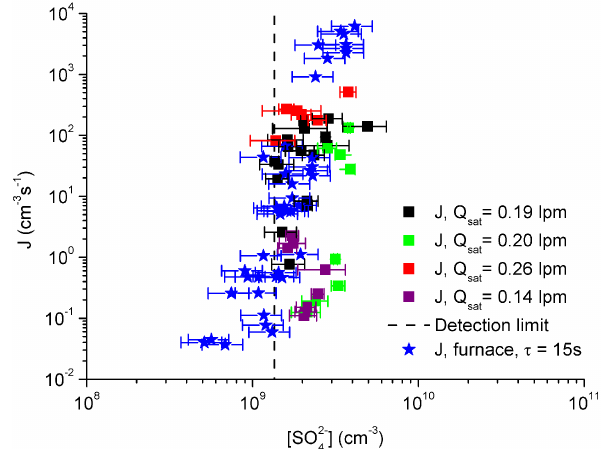
Figure 9. Formation rates J as a function of total-sulfate concen- tration [SO 2 − ] measured with MARGA or bubbler with different 4 saturator flow rates. MARGA’s detection limit is marked with the dashed line. Relative humidity RH ∼ 30% and nucleation tempera- ture T = 298K. Sulfuric-acid vapor was produced with the furnace method (Brus et al., 2010) for bubbler measurements and with the saturator method for MARGA.